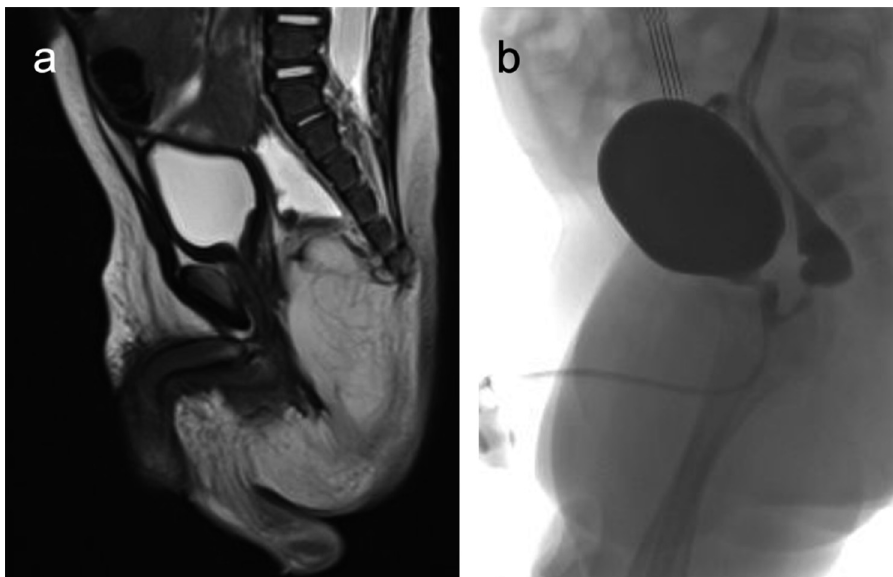
Fig. 1 ( A ) Preoperative magnetic resonance imaging (MRI) showing the anorectal malformation (ARM) with a rectourethral prostatic fi stula. ( B ) Micturating cystourethrogram (MCUG) demonstrating a rectourethral prostatic fi stula with a maximum diameter of